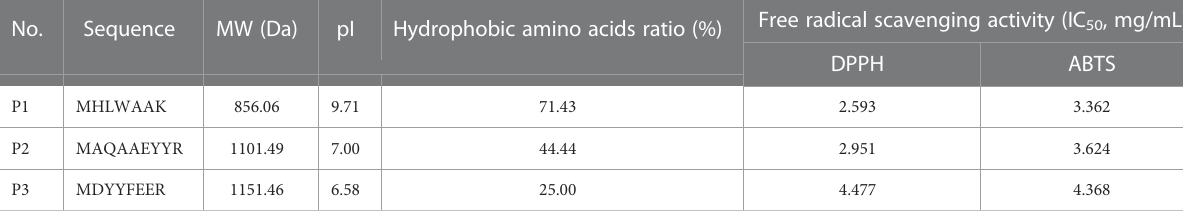
TABLE 2 Sequencing and free radical scavenging activity results of antioxidant peptides.